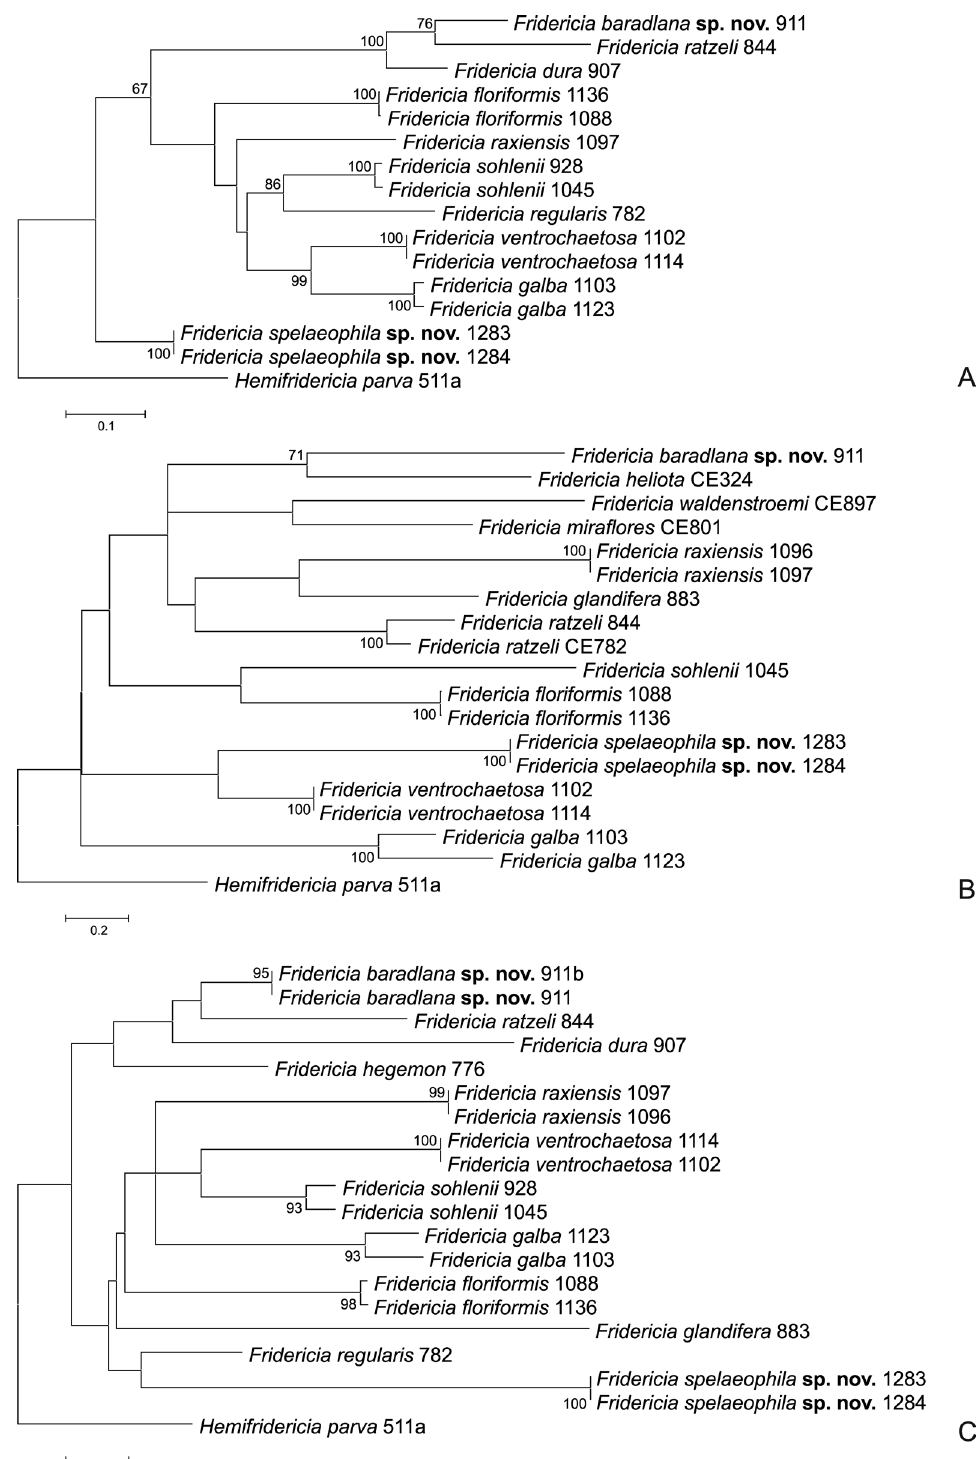
Fig. 6. Maximum likelihood (ML) trees of studied Fridericia species based on the ITS region (A), CO1 (B) and H3 genes (C). Bootstrap values greater than 50 are shown at the nodes. Sequences from new species described here appear in bold. A . ML tree of the ITS region based on 821 nucleotide positions. B . ML tree of the CO1 gene based on 388 nucleotide positions. C . ML tree of the H3 gene based on 202 nucleotide